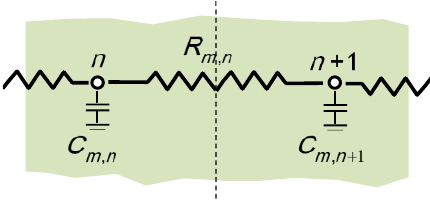
Figure 2. RC thermal network: n and n + 1-th nodes of the m -th building element.